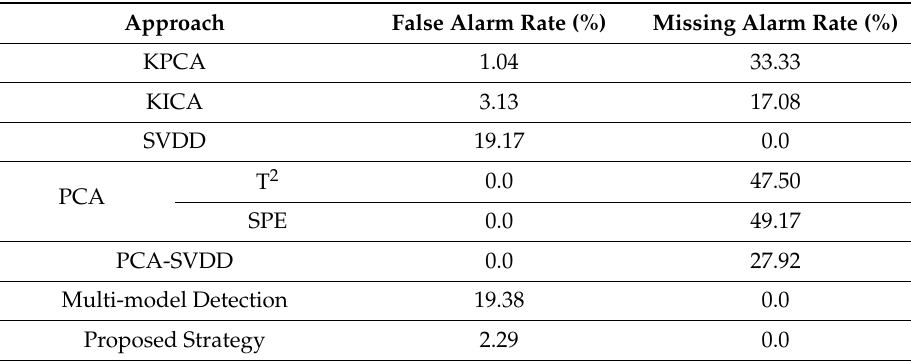
Table 2. Comparison of fault detection results.